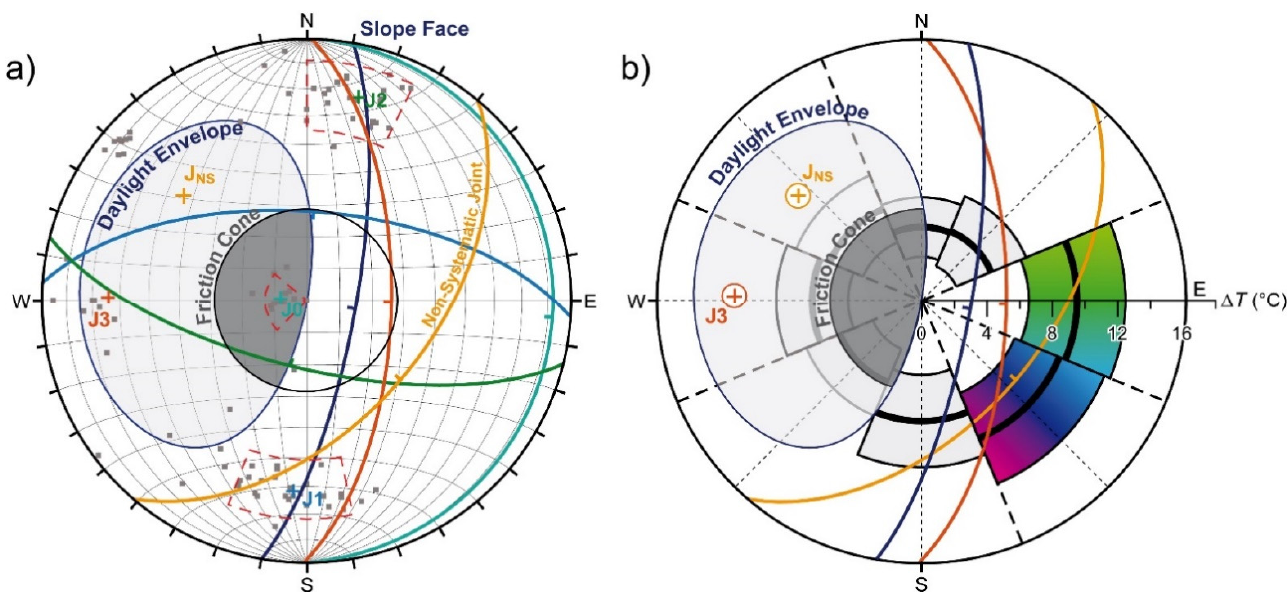
Figure 12. ( a ) Kinematic and dynamic compatibility analysis for the rock block monitored at the Acuto field laboratory to planar sliding of joints according to the daylight envelope and the friction cone limit, assuming a ± 20 ◦ dip direction and a tilt-test based 28 ◦ friction angle. ( b ) Mean and standard deviation ( µ ± 1 σ ) temperature range over the diurnal thermal cycle acting on the predisposed discontinuities are highlighted.